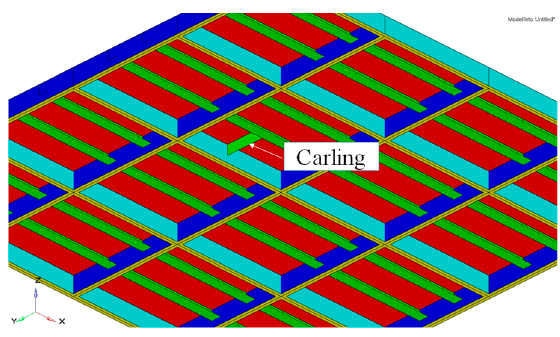
Figure 11. Local reinforcement with the carling. Table 9. Nonlinear FEA results for hull deck structures with reduced deck thickness of 6 mm.